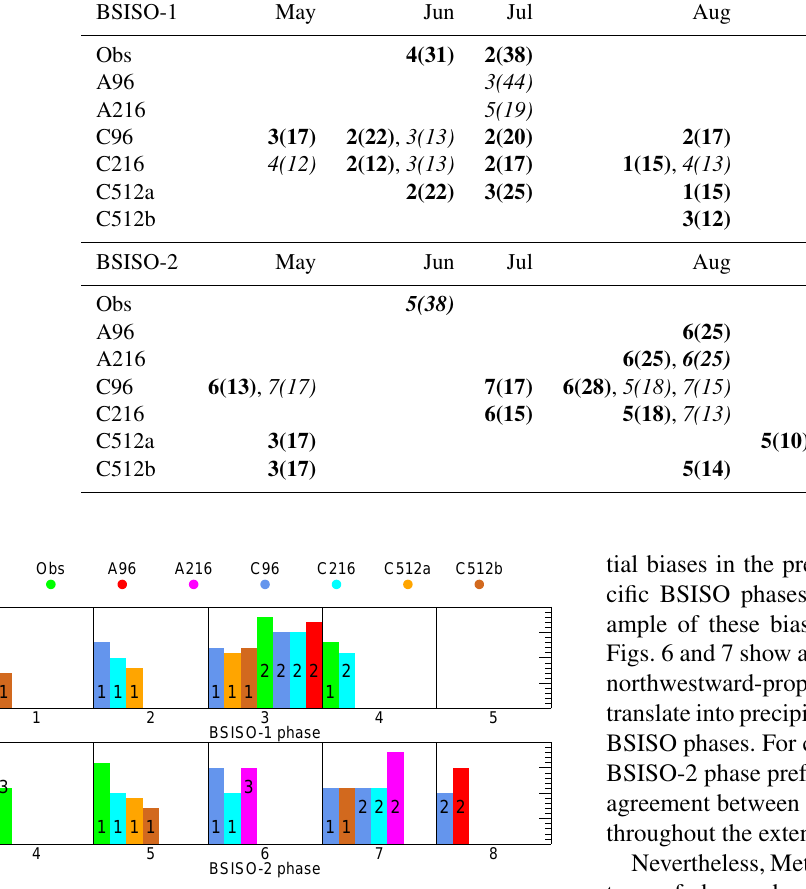
Figure 11. Histograms show the percentages of the wettest 10% of pentads that occur during phases 1–5 of BSISO-1 (a) and phases 4–8 of BSISO-2 (b) , when these are statistically significantly in- creased at the 5% level compared to climatology, as indicated by a two-sided binomial test. Numbers overlaid on the histograms in- dicate the pattern number. BSISO phases that are not listed are not associated with any anomalously increased